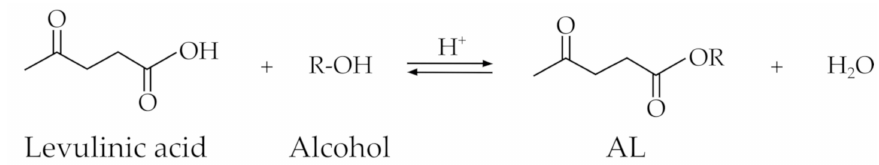
Figure 1. AL synthesis by acid-catalized esterification of levulinic acid.